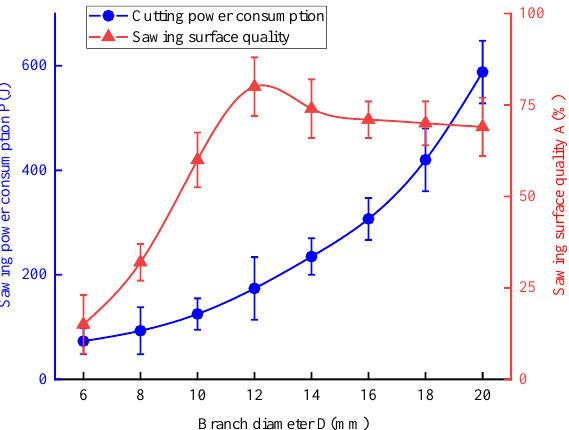
Figure 6. Sawing effect with different branch diameters ( Note: Sawing speed 40 m/s; feeding speed 0.35 m/s; cutting inclination 10°; number of teeth 80; moisture content 26.6~28.4% ).